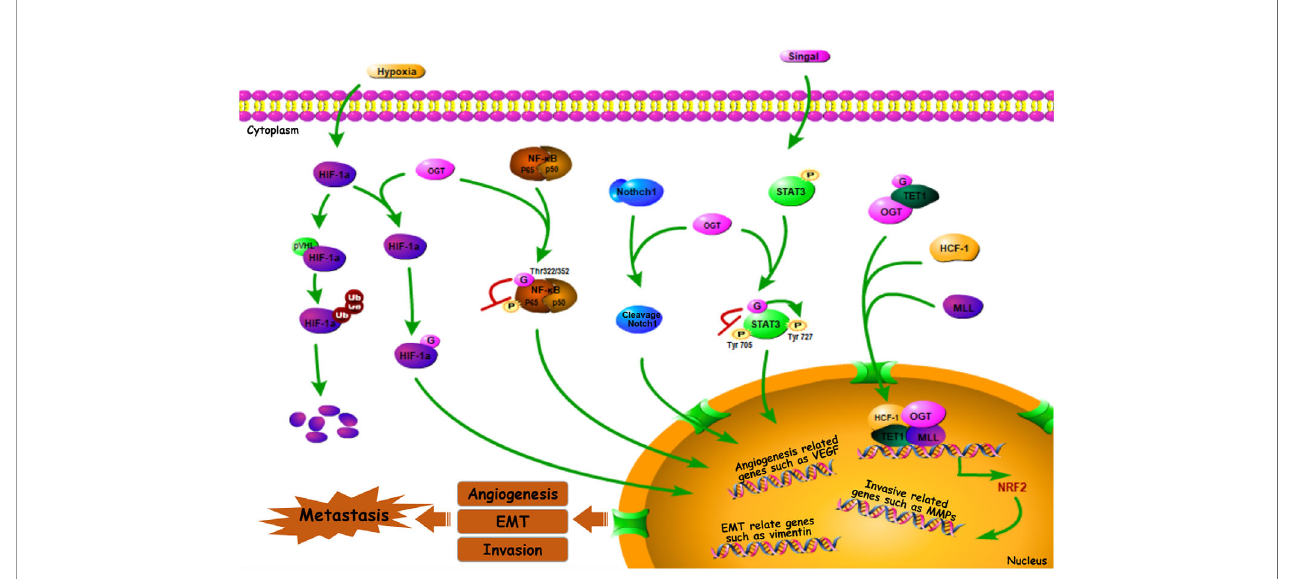
FIGURE 2 | O -GlcNAc-modi fi ed transcription factors in cancer metastasis. Some O -GlcNAc-modi fi ed metastasis related transcription factors such as HIF-1 a , Notch1, NF- k B, STAT3, Nrf2 can impact cancer metastasis by affecting downstream genes (or proteins) (49 –